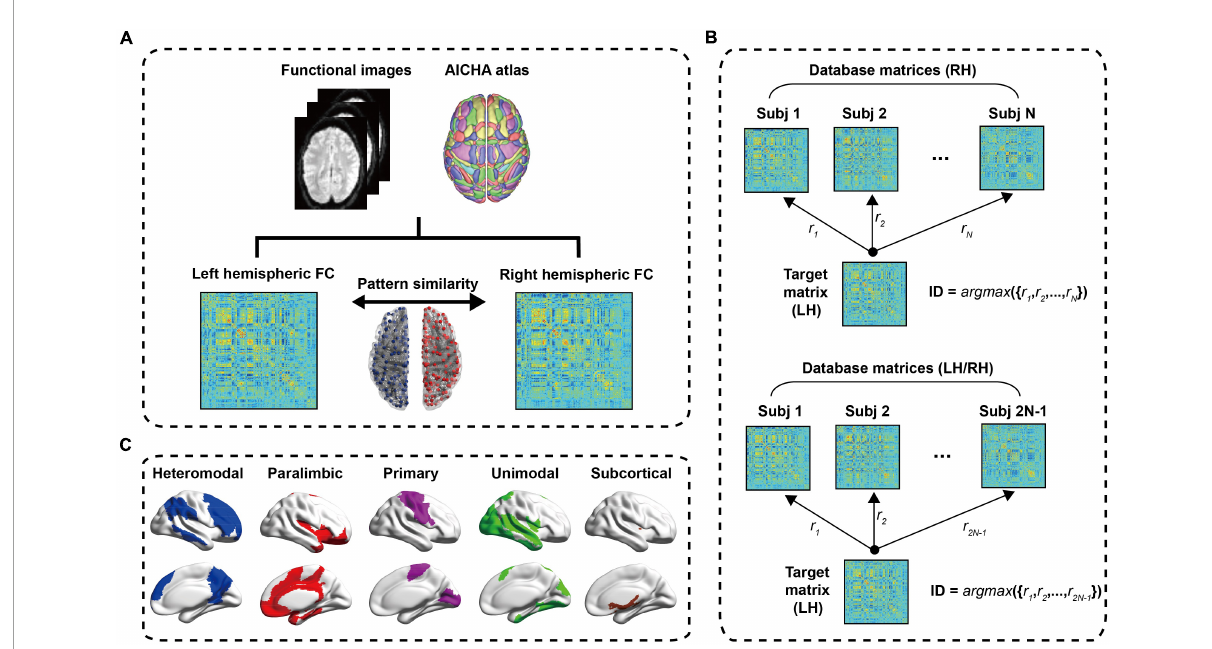
FIGURE1 The process flow chart. (A) Data preprocessing. After a series of preprocessing steps, a 384 × 384 symmetric resting state FC matrix is obtained, and the left hemisphere and right hemisphere is 192 × 192 symmetric connection matrices, respectively. The Pearson correlation of left hemisphere and right hemisphere of intra-subject is defined as the hemispheric similarity of functional connectivity (HSFC). (B) Schematic diagram of individual identification; (C) the cortical distribution of the five sub-modules. LH, Left hemisphere; RH, Right hemisphere.